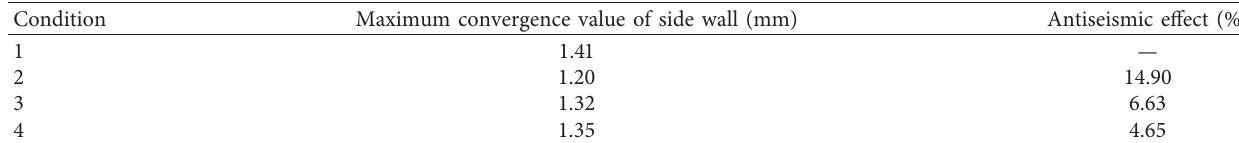
Table 3: Maximum convergence value of side wall.